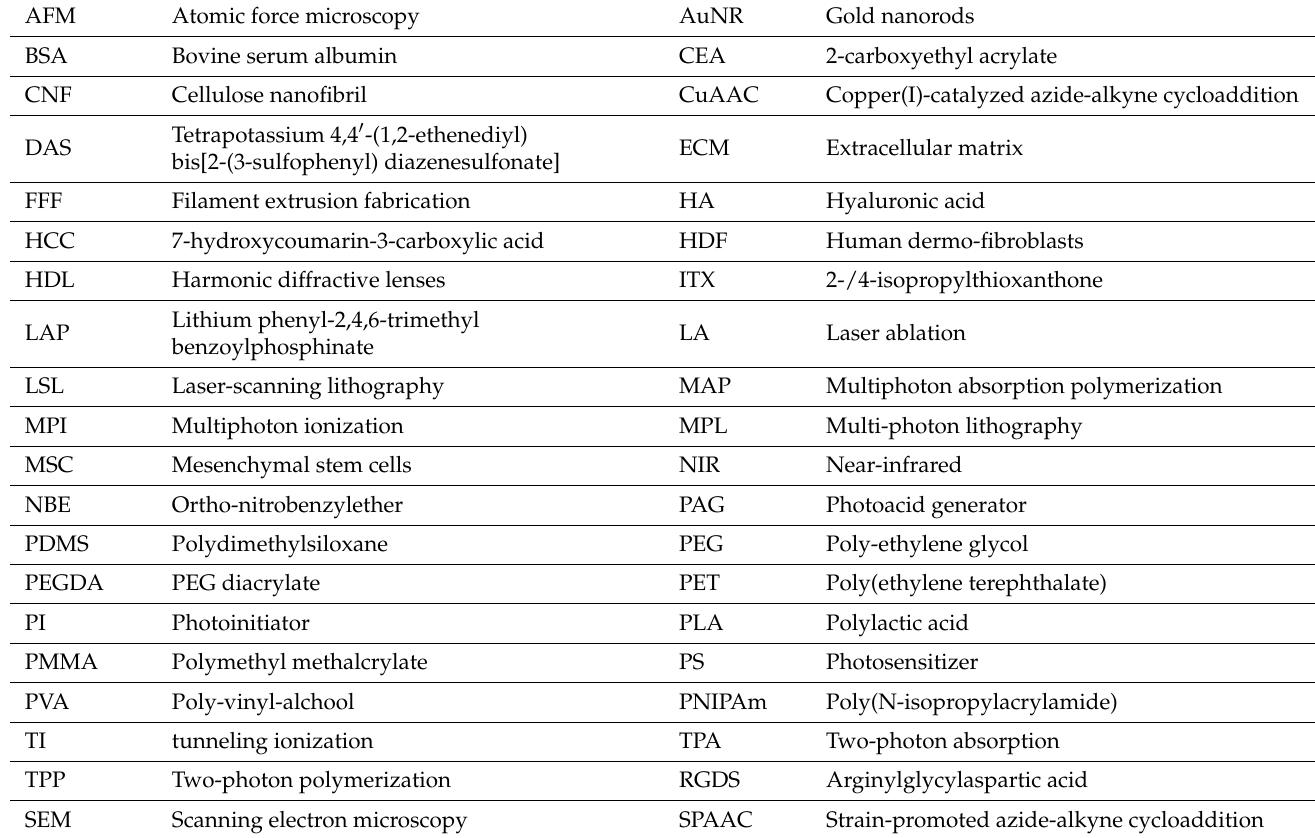
Table 1. Acronyms,